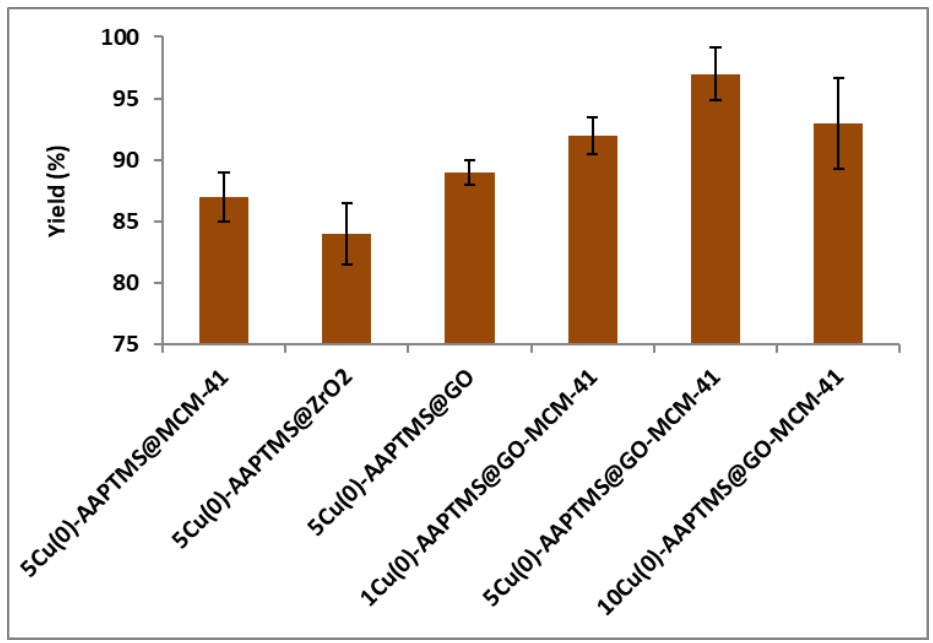
Figure 6. The activity of different catalysts towards the C-C Ullmann coupling reaction a . a Reaction conditions: Temperature, 80 °C; time, 5 h; catalyst, 0.03 g; solvent (water), 10 mL. Reactants: Aryl halides (4.5 mmol); HCOONa (1.10 g); KOH (1.40 g). Li et al. [34] reported that MOF- 253 · 0.05PdCl 2 catalyst gives 99% yield in DMSO/EtOH (20:1) at 120 ◦ C for 10 h, while Pd/Ph-SBA-15 catalyst reportedly gave 75% yield at 100 ◦